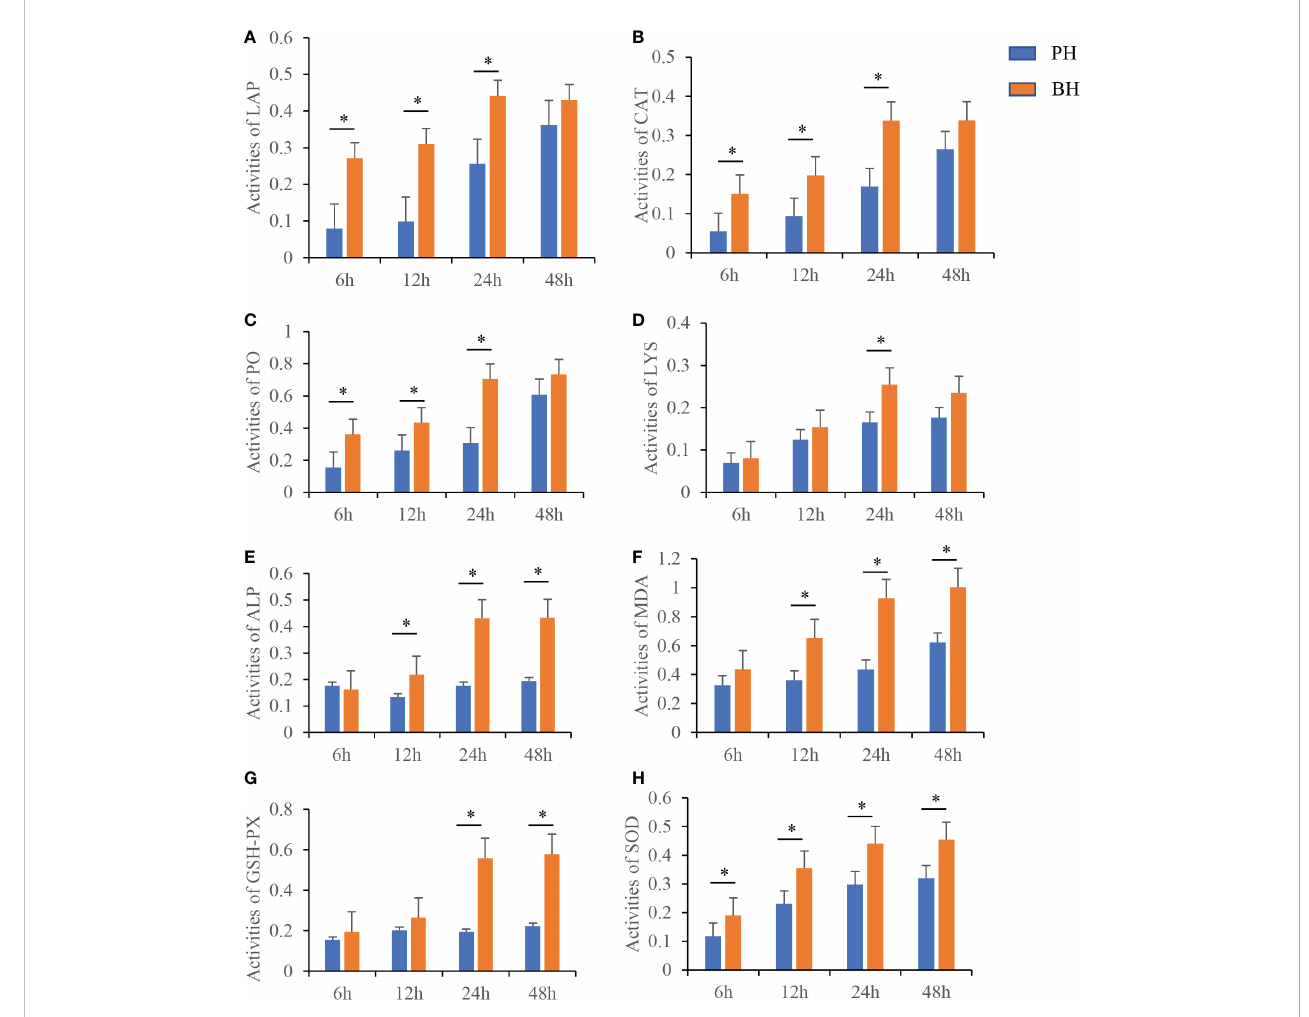
FIGURE 6 Changes of different activity levels at different time after butyrate stimulation. Activity of LAP (A) , CAT (B) , PO (C) , LYS (D) , ALP (E) , MDA (F) , GSH-Px (G) and SOD (H) in serum at different time points in PH and BH group after transplantation. Values were shown as mean ± SD (N = 3), * P <